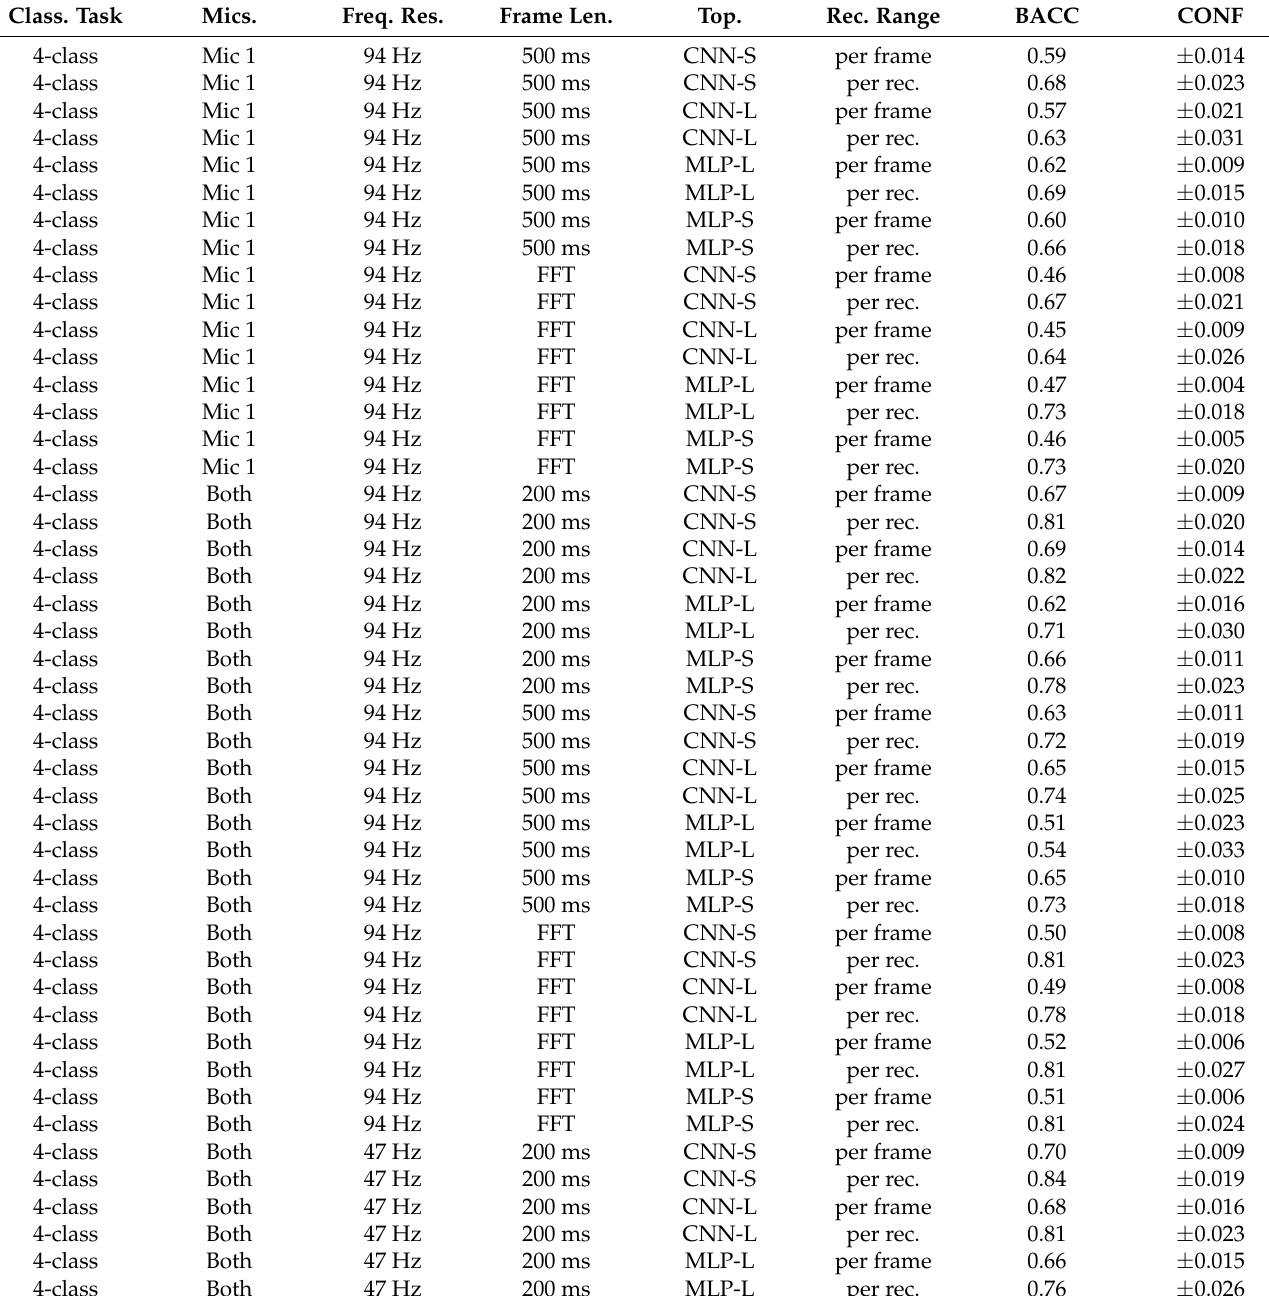
Table A2. Detailed results of all performed exercises. Abbreviations: classification task (Class. Task), microphones (Mics.), frequency resolution (Freq. res.), classification time frame length (Frame len.), neural network topology (Top.), recognition range (Rec. range), balanced accuracy (BACC) and confidence interval (CONF). Class. Task